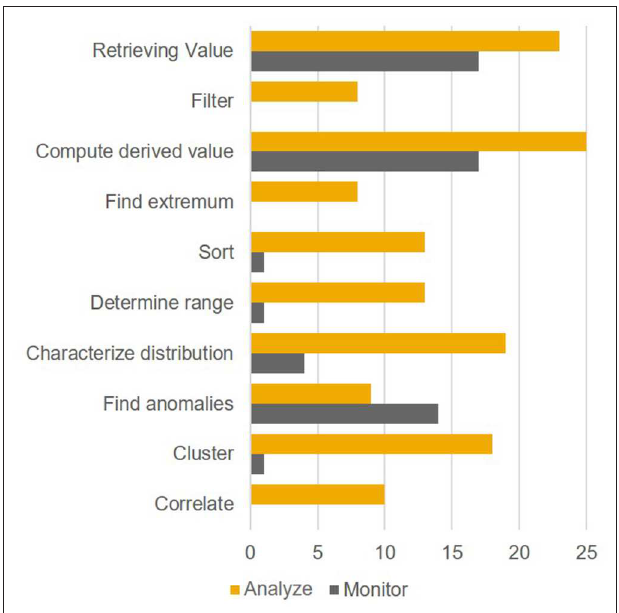
FIGURE 4 | Study 3: Distribution of low-level tasks within the intents.